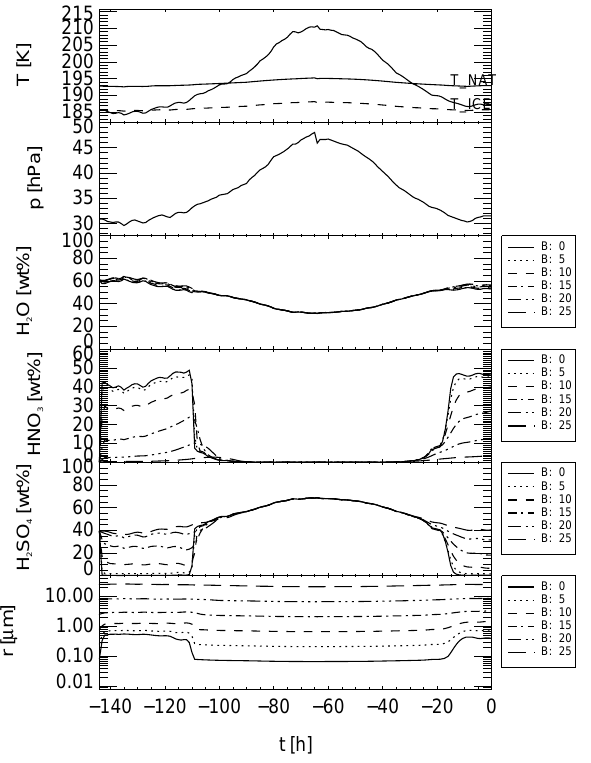
Fig. 6. Microphysical box model simulation for the observation at Esrange on 22 January 19:00UT (22km). Shown is the devel- opment of the temperature in K, the pressure in hPa, the weight fraction of water, nitric acid and sulfuric acid in wt% as well as the particle radius in µm for the different particle size classes denoted by B0–B25 (B0 = smallest and B25 = largest size class). Note: the simulations are performed forward in time, thus, the end of the sim- ulation coincides with the measurement and the starting point of the trajectory.